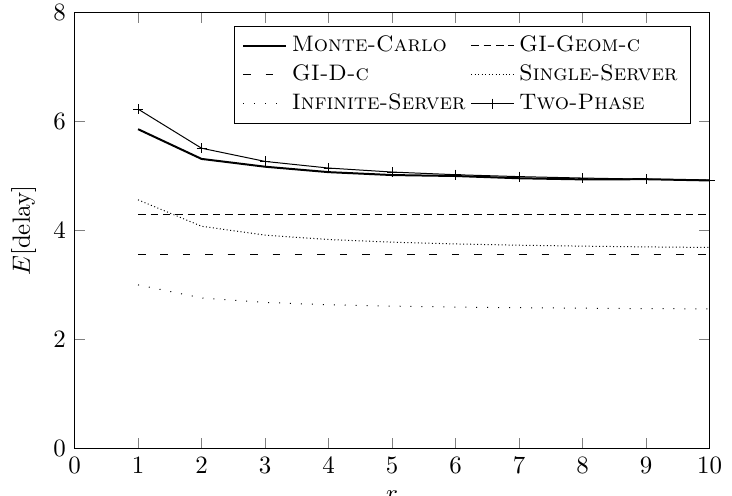
Figure 6. Mean customer delay for a 5-server system with Poisson arrivals, shifted negative-binomial service demands with 5 phases and mean τ = 10, and negative-binomial service capacities with r phases and mean µ = 5, with load ρ = 0.95, for various r , as estimated by various